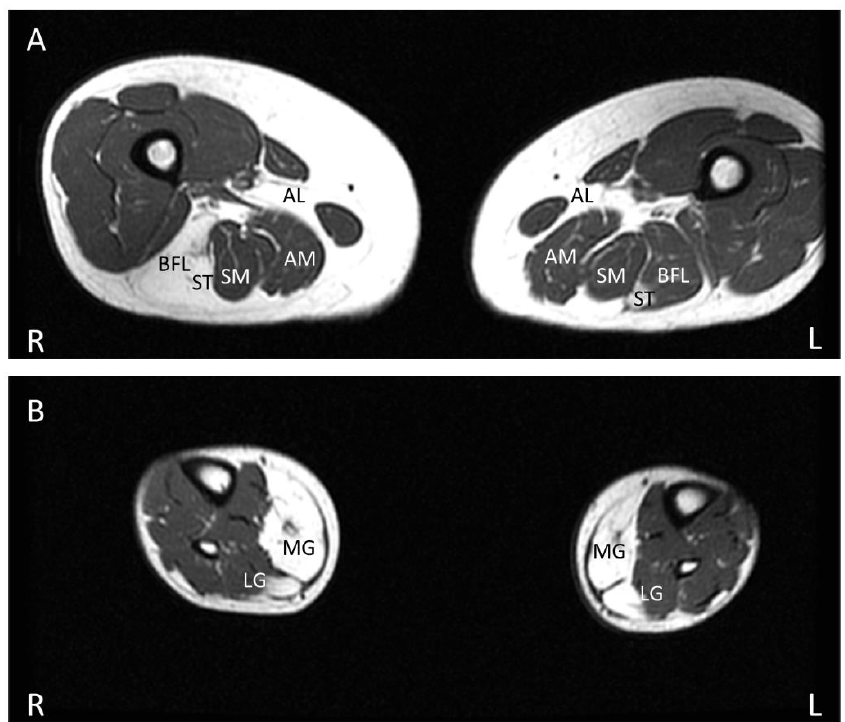
Figure 4. T1-weighted lower limb MRI in a patient with LGMDR12, calf atrophy and longstanding history of exercise intolerance and rhabdomyolysis showing asymmetrical fatty replacement of pre- dominantly posterior lower limb compartment muscles, including bilateral adductor longus, long head of right biceps femoris, and bilateral semitendinosus ( A ) and bilateral medial gastrocnemius and parts of lateral gastrocnemius ( B ). AL — adductor longus, AM — adductor magnus, SM — semi- membranosus, ST — semitendinosus, BFL — long head of biceps femoris, MG — medial gastrocnem- SM—semimembranosus, ST—semitendinosus, BFL—long head of biceps femoris, MG—medial ius, LG — lateral gastrocnemius. gastrocnemius, LG—lateral